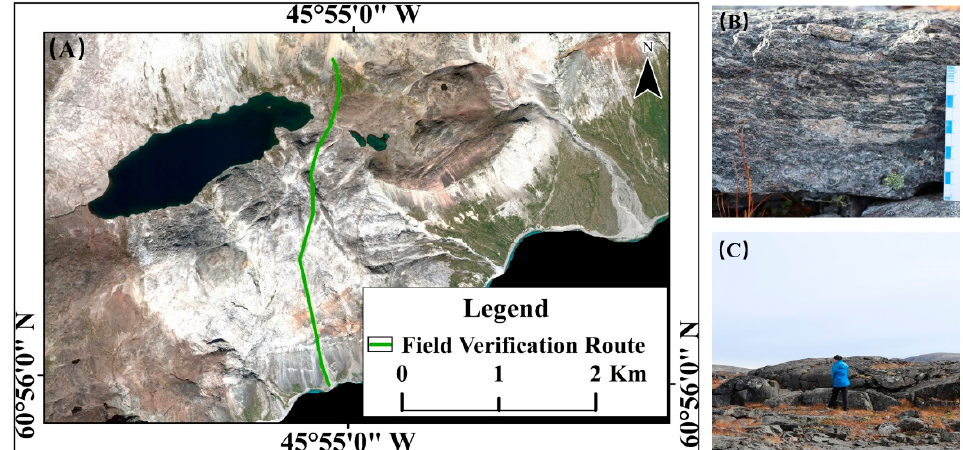
Figure 12. ( A ) Field validation route map (the base image is a combination of Sentinel-2 ′ s 432 bands); ( B , C ) Greyish-black dense Lujavrite.